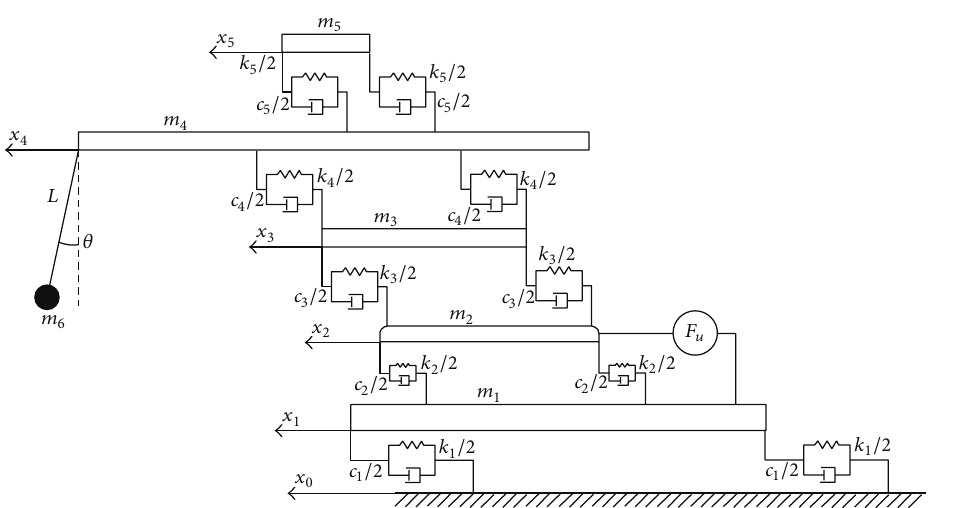
Figure 3: Dynamic model of the crane under seismic